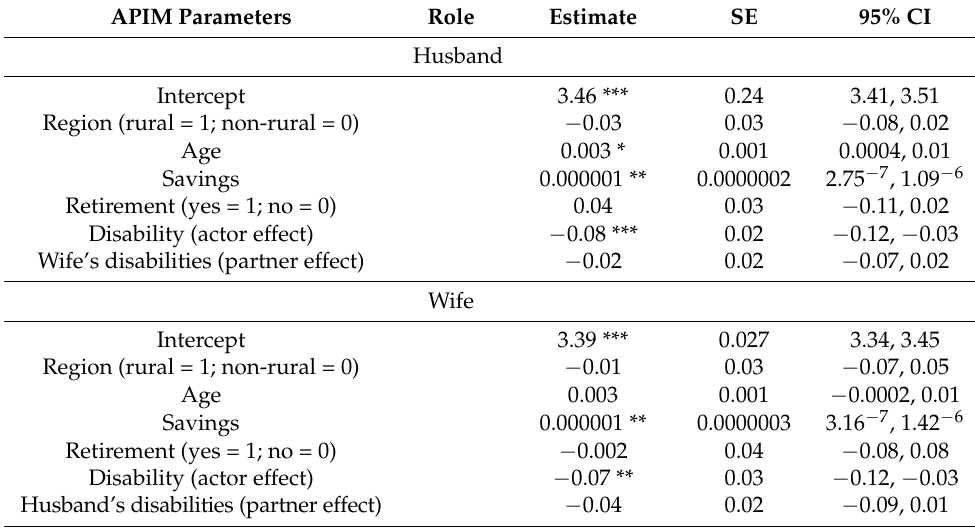
Table 1. The results of APIM for the dyadic effect of overall disabilities on life satisfaction.